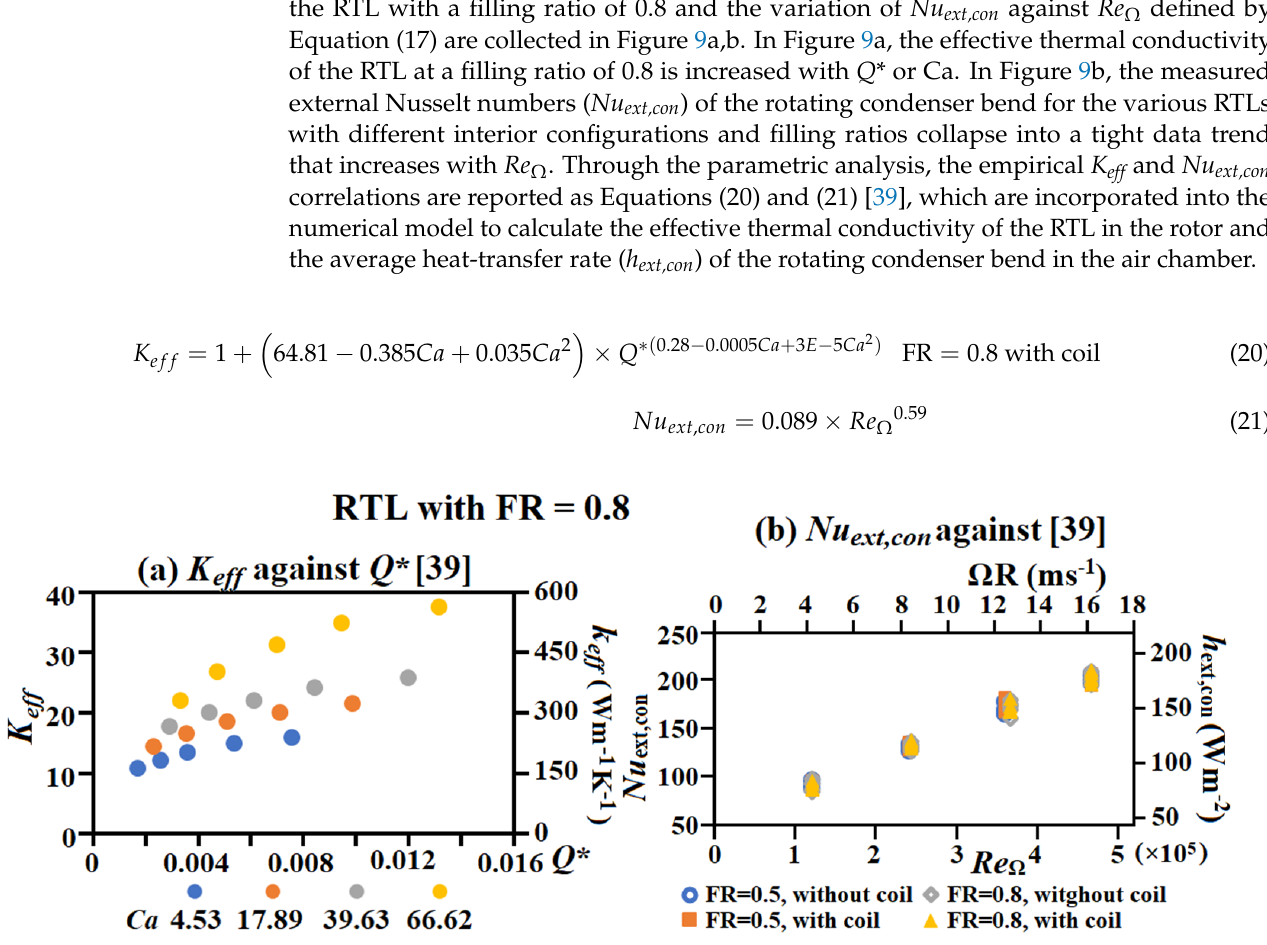
Figure 9. Variations of ( a ) K eff against Q * at various Ca ( b ) Nu ext,con against Re Ω for the RTL with filling ratio of 0.8 [39].